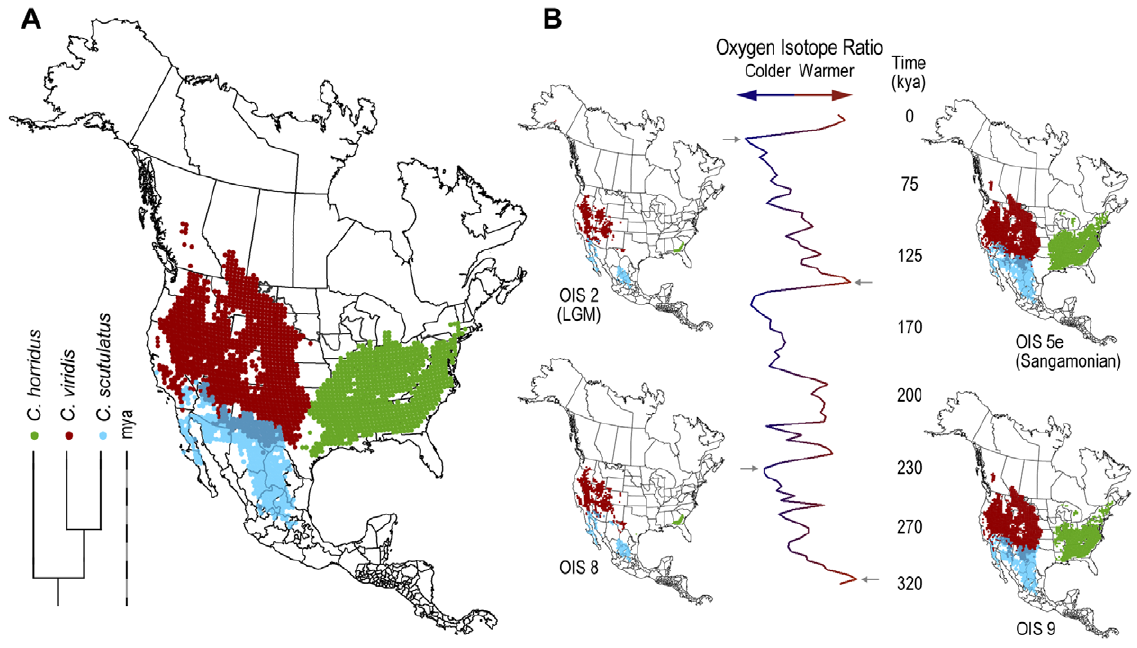
Figure 5. Paleophylogeographic distribution models for three species of rattlesnake ( Crotalus ). A, Phylogeny and modern geographic distribution models mapped onto modern climatic conditions. The dark gray curve represents the southern extent of glaciers during the LGM. B, Composite oxygen isotope curve for the last 320 ky inset with four paleophylogeographic reconstructions at four points, two glacial and two interglacial, to illustrate the effects of climate changes and phylogeny on the distribution of suitable habitats. Phylogenetically scaled climate envelopes were projected onto isotopically scaled paleoclimate models to generate these maps. Supplemental videos show animations of the paleophylogeographic distributions through the last 320 ky for these three species (Video S1) and for the remaining species (Video S2 and S3).